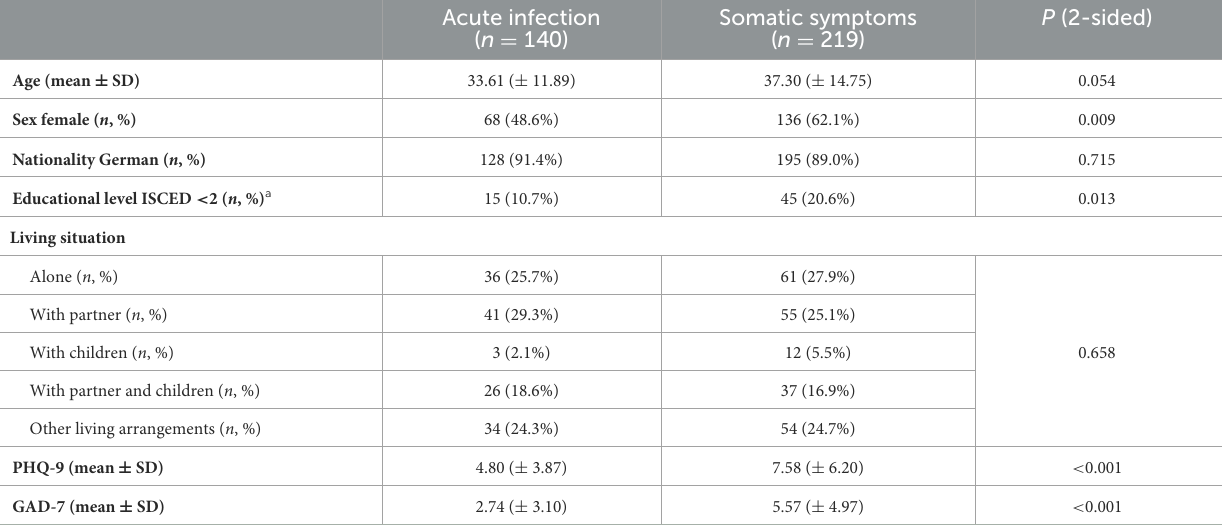
TABLE 1 Sociodemographic characteristic and severity of depression and